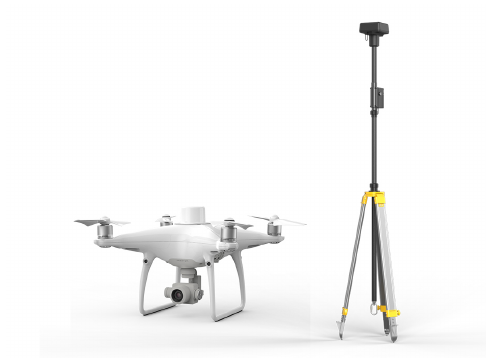
Figure 1 (b) DSM of the surveyed area. Figure 2 The DJI Phantom 4 RTK (left) and the D-RTK 2